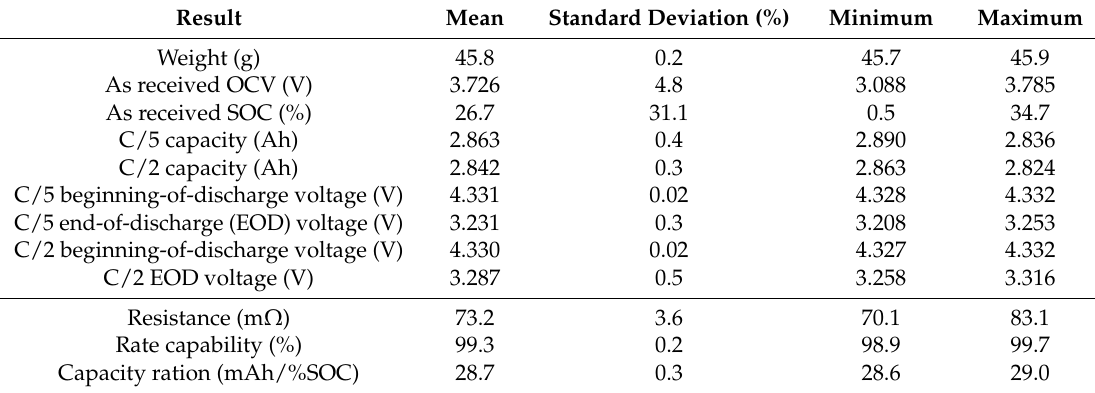
Table 1. Summary of the initial conditioning and characterization test (ICCT) test results.